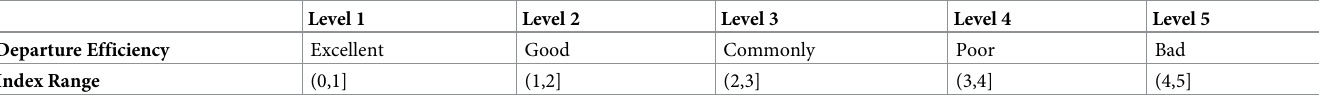
Table 7. Passenger flow departure efficiency evaluation classification